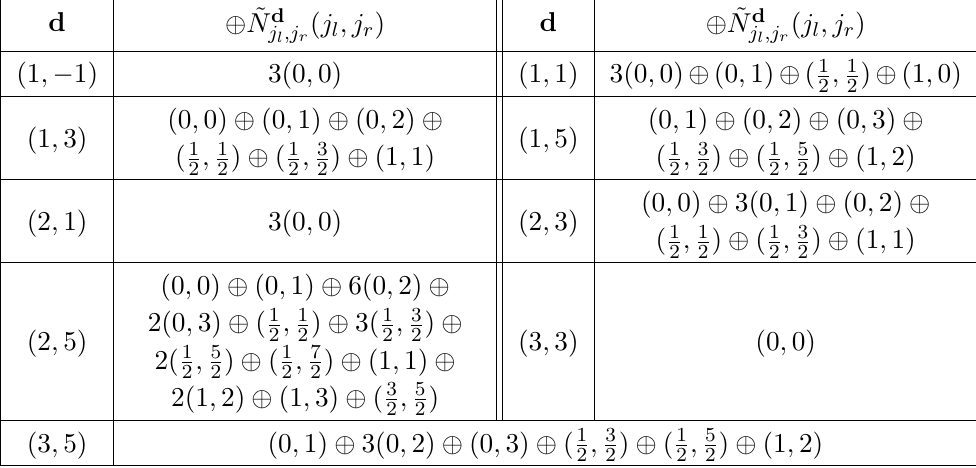
Table 5 . Spectrum of the Wilson loop operator in the rank-3 symmetric representation in the SU(2) 0 theory for d 1 ≤ 3 and d 2 ≤ 6